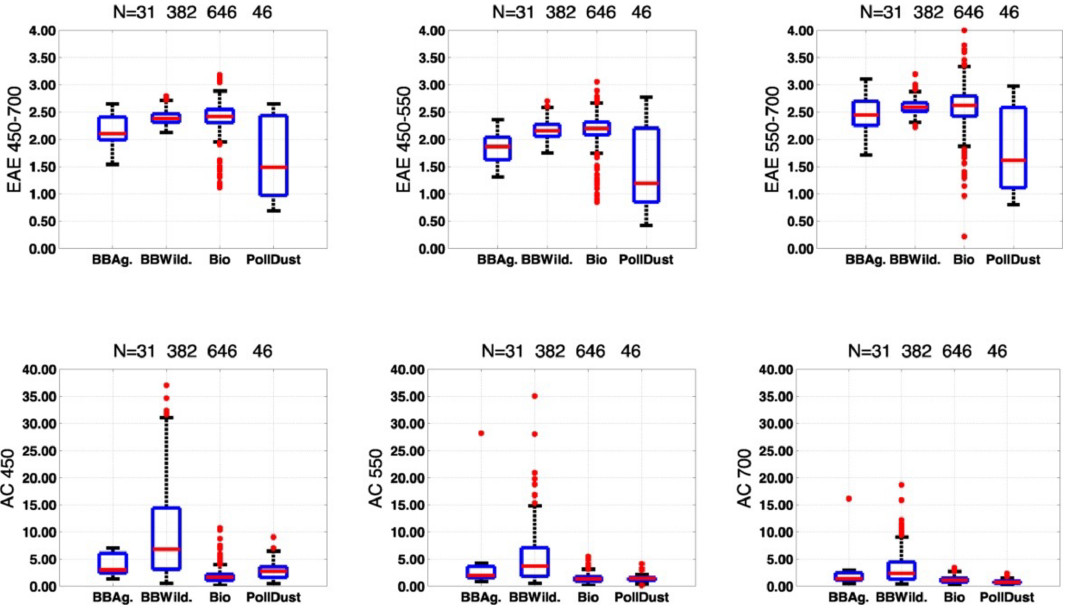
Figure A2. EAE (450–700nm, 450–550nm, 550–700nm) and AC (450, 550 and 700nm) per PS-AMT. In each blue box, the red horizontal line indicates the median, and the bottom and top edges of the box indicate the 25th and 75th percentiles, respectively. The black whiskers extend to the most extreme data points not considered outliers, and the outliers are plotted individually using red points. Let us note that the LARGE EC measurements at 700nm experienced issues during the latter half of SEAC 4 RS (Yohei Shinozuka, personal communication, 2018). AC: absorption coefficient; EAE: extinction Ångström exponent. Numbers in the title correspond to the number of points behind each box–whisker plot for the respective BBAg., BBWild., Bio. and PollDust PS-AMTs.